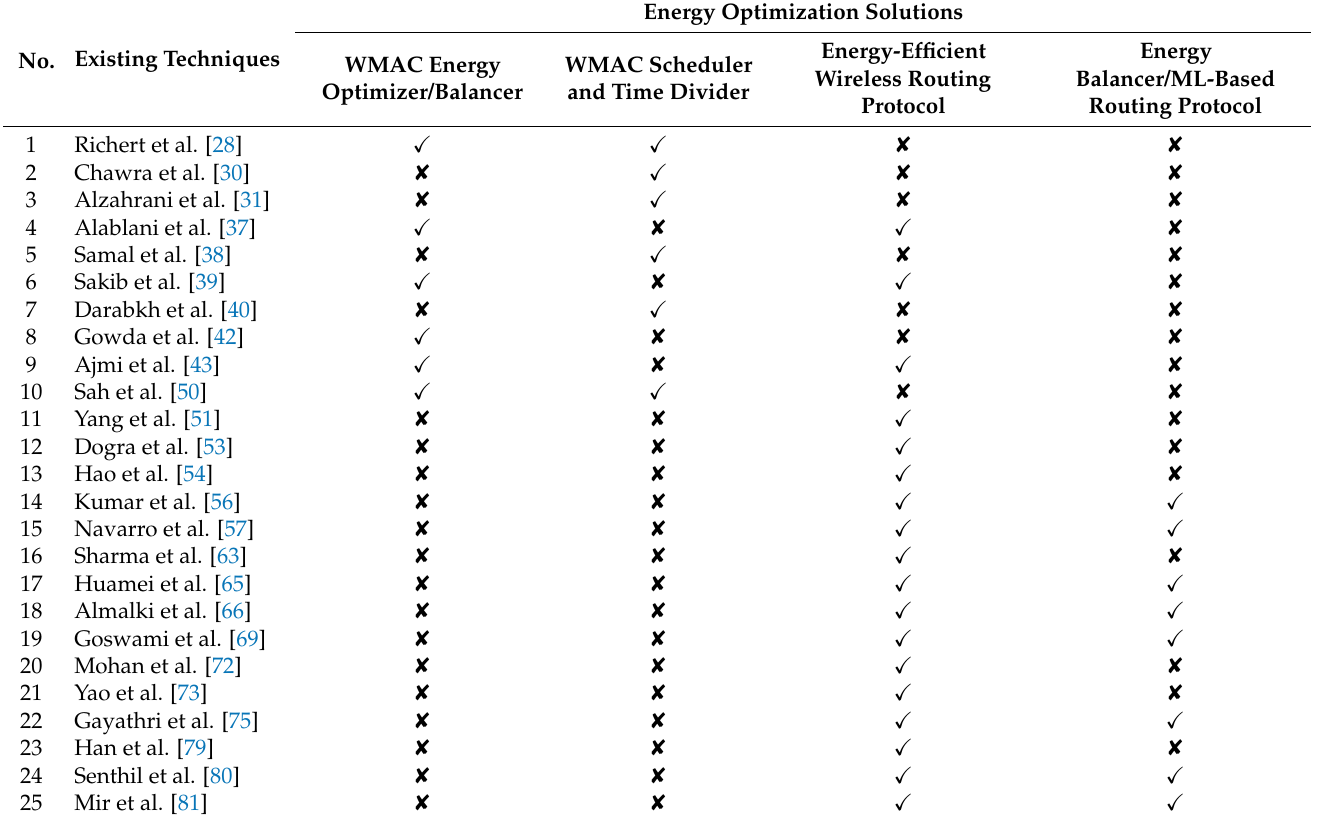
Table 4. Related contributions on energy-efficient WMAC and routing protocols.